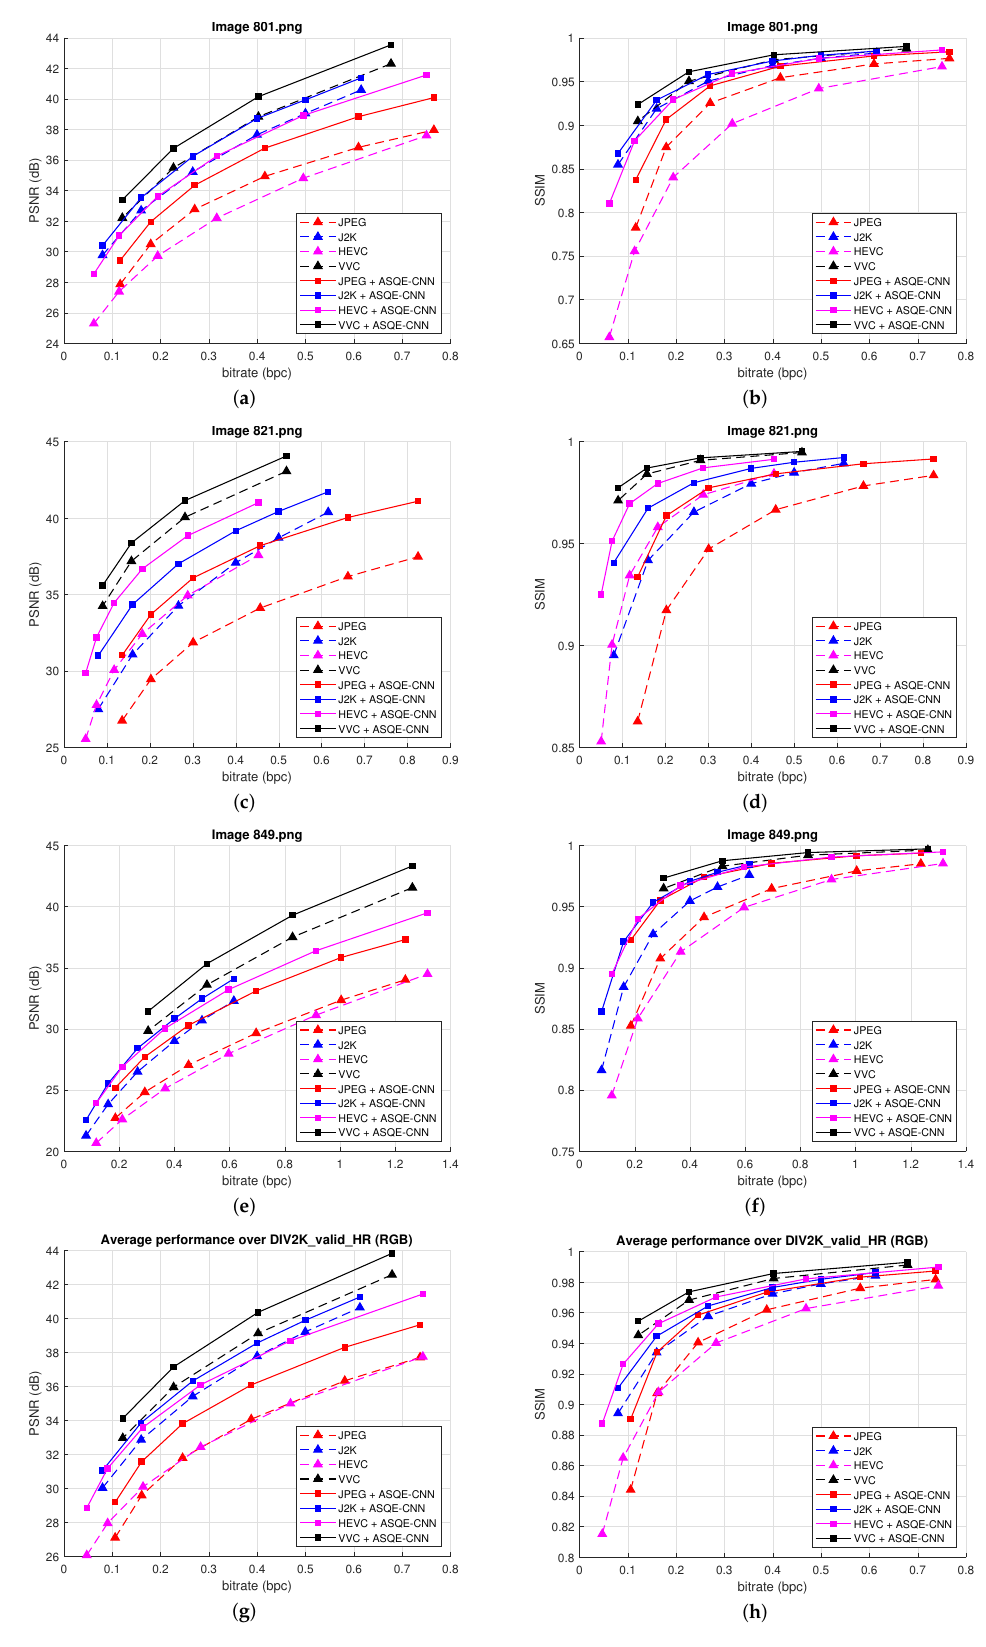
Figure 5. Rate-distortion results for three images, ( a , b ) Image 801.png , ( c , d ) Image 821.png , ( e , f ) Image 849.png , and ( g , h ) over DIV2K_valid_HR [52]. ( Left ) bpc vs. PSNR results. ( Right ) bpc vs. SSIM